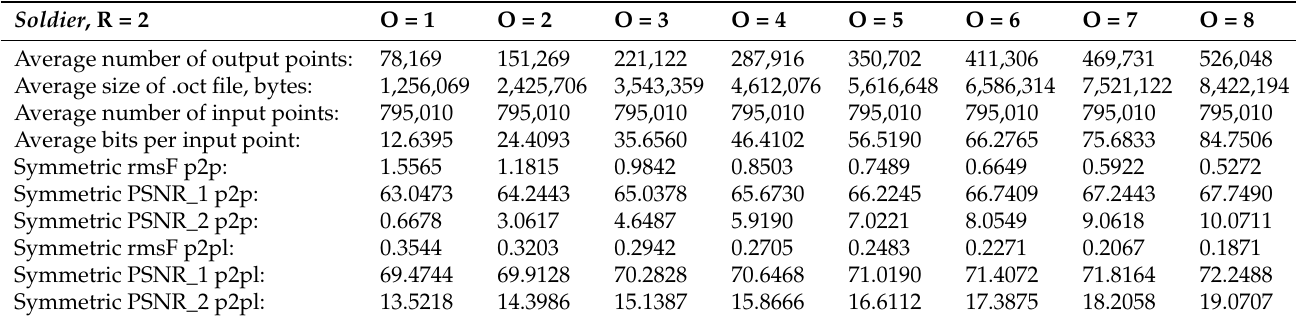
Table 16. Octree reduction using 3DTK toolkit, with voxel size “R” = 2 and different parameters for randomized octree based point reduction with “O” points per voxel, for the Soldier point